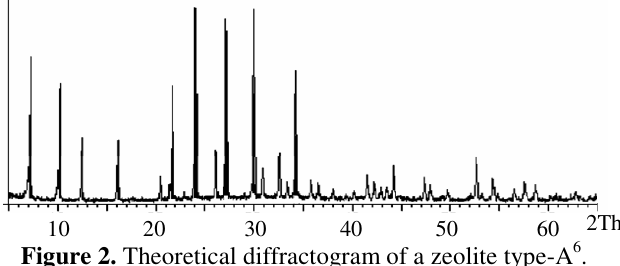
Figure 2. Theoretical diffractogram of a zeolite type-A 6